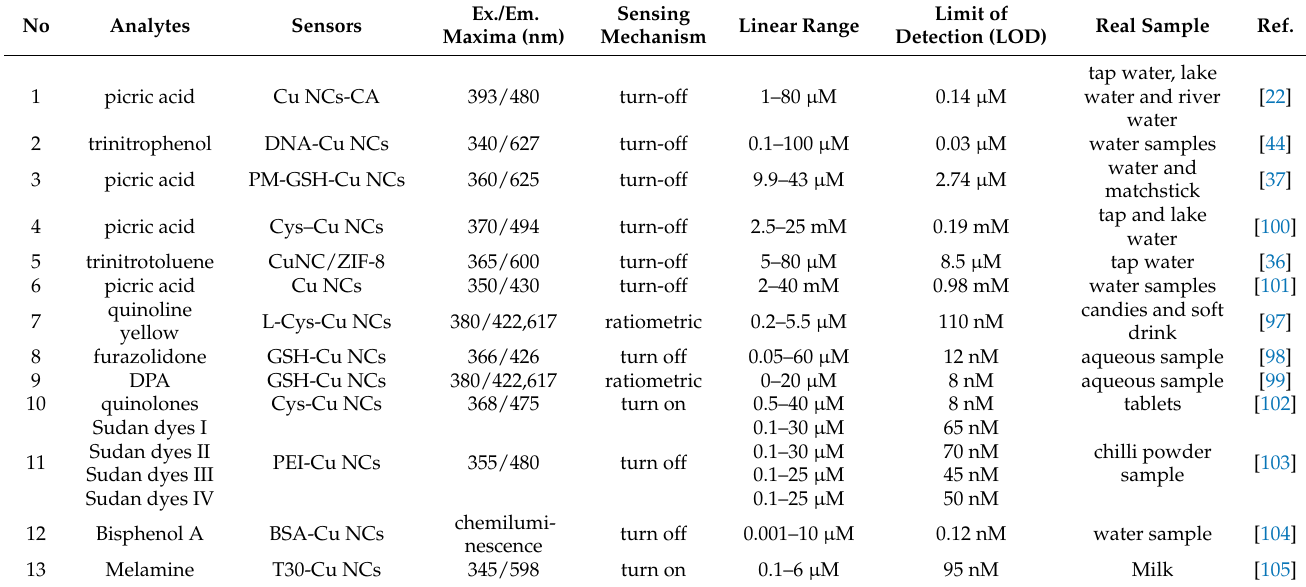
Table 4. List of fluorescent probes based on Cu NCs for detection of other